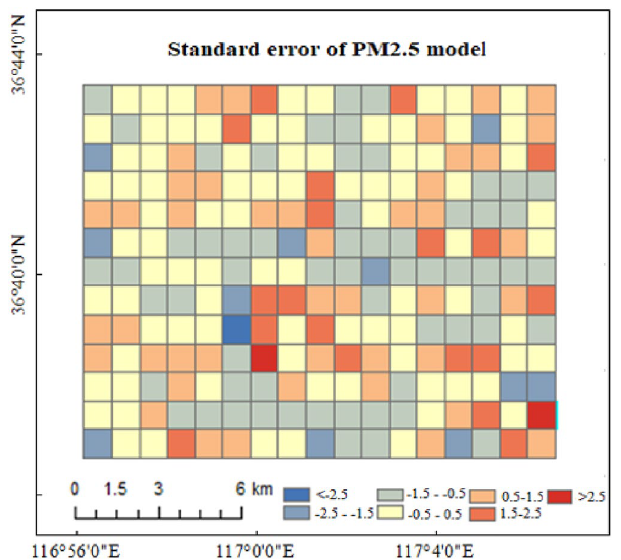
Figure 5. Standard deviation based on the GWR model (The darker the color, the greater the standard deviation). Map created in ArcMap 10.5 of the Environmental System Resource Institute, Inc. (https:// www. esri. com/ softw are/ arcgis/ arcgis- for- deskt